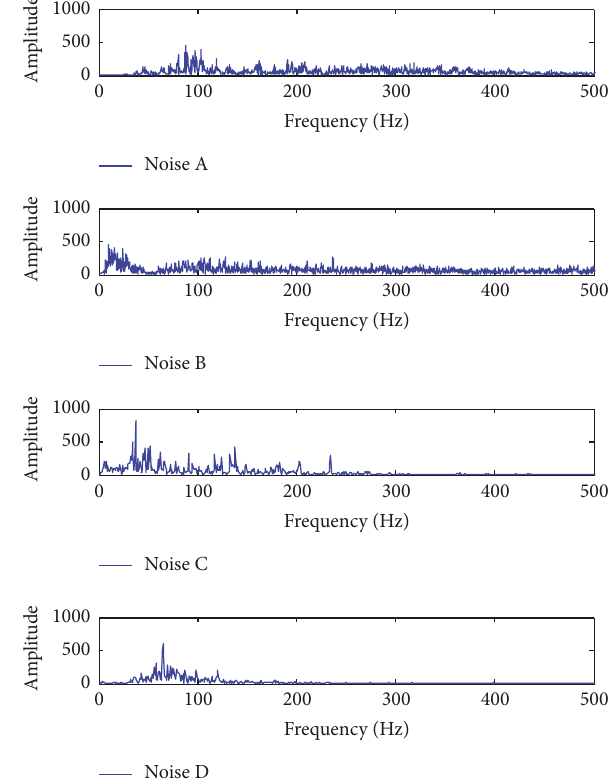
Figure 4: The spectrums of real ship radiated noise signals. RSSD is operated, we set the parameters 𝑄 1 = 8 , 𝑟 1 = 3 , and 𝐽 1 = 28 for high- Q TQWT and 𝑄 2 = 1 , 𝑟 2 = 3 , and = 3 for low- Q TQWT, respectively. It can be obviously 𝐽 2